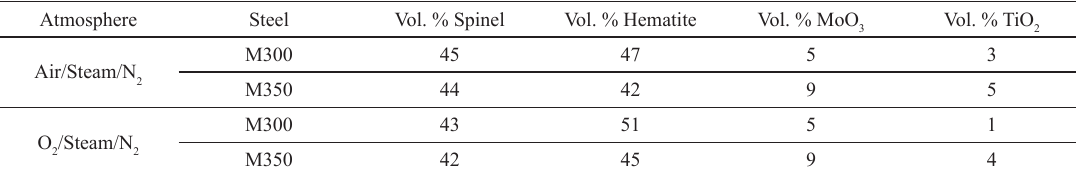
Table 2. Vol. % content for each constitutive phase present in the oxide layer produced in both maraging alloys. Atmosphere